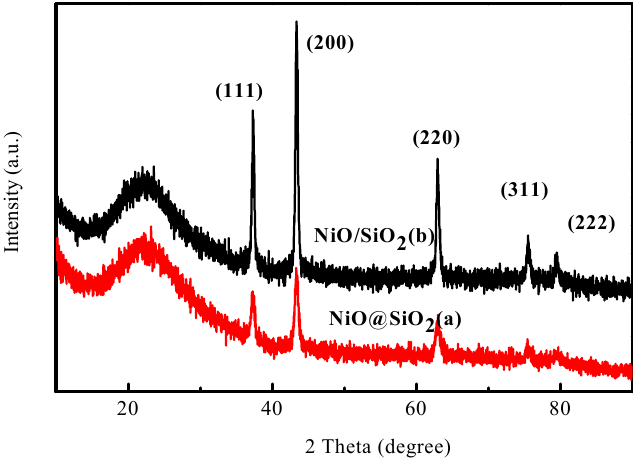
Figure 1. XRD (X ‐ ray diffraction) patterns of the as ‐ obtained NiO@SiO 2 ( a ); and NiO/SiO 2 ( b ) catalysts. Figure 1. XRD (X-ray diffraction) patterns of the as-obtained NiO@SiO